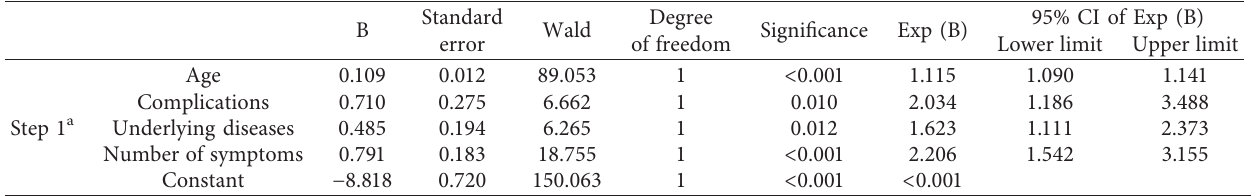
Table 4: Influencing factors for COVID-19 patients to develop severe illnesses in classification analysis.